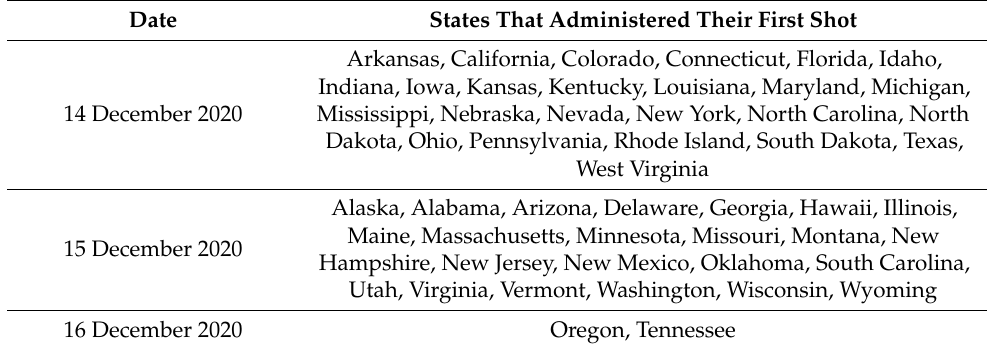
Table 1. The administration date of the first COVID-19 vaccine shot in every state.